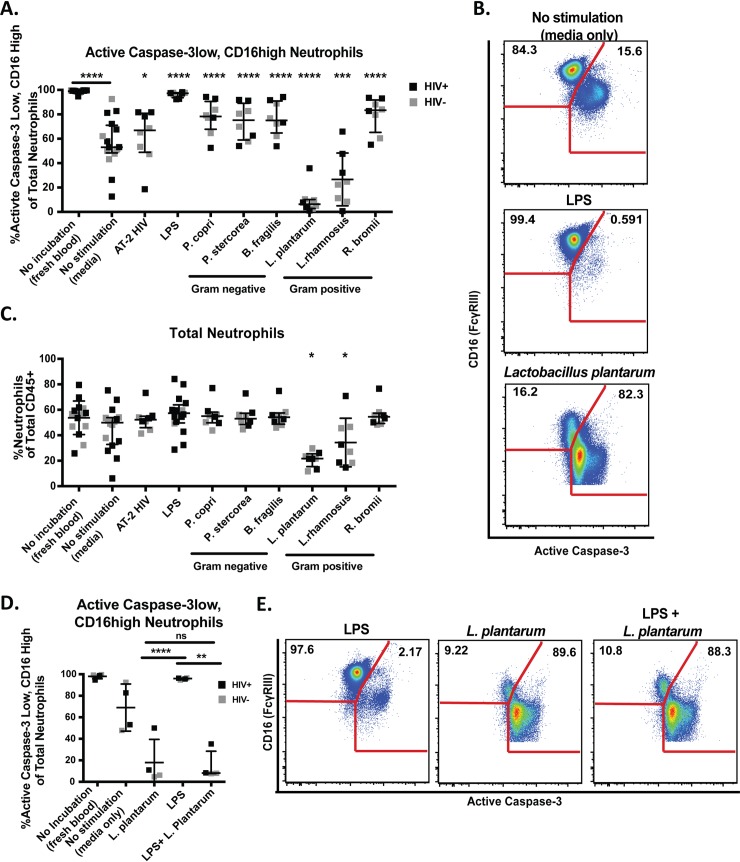
Mucosal bacteria differentially affect neutrophil lifespan.A.) Percentage of active Caspase-3low, CD16high neutrophils in whole blood incubated with different HIV altered mucosal bacteria as measured by flow cytometry. B.)Example staining of active Caspase-3low, CD16high neutrophils after stimulation with LPS and Lactobacillus plantarum. C). Total neutrophil frequencies as a percentage of total CD45+ leukocytes in whole blood incubated with different HIV altered mucosal bacteria. D.) Percentage of active Caspase-3low, CD16high neutrophils in whole blood incubated with LPS alone, Lactobacillus plantarum alone, and LPS with L. plantarum as measured by flow cytometry. E.) Example staining of active Caspase-3low, CD16high neutrophils after stimulation with LPS alone, Lactobacillus plantarum alone, and LPS with L. plantarum. Statistical significance was determined using a paired one-way ANOVA followed by a Dunnett’s post-hoc analysis for multiple comparisons comparing each group to the media control. Asterisks (*) indicate significance by adjusted p-value from post-hoc analysis (*p <0.05, ** p <0.01, *** p <0.001, ****p<0.0001). The statistical difference between fresh blood and blood incubated in media alone was assessed using a Wilcoxon signed-ranked test (****p<0.0001).